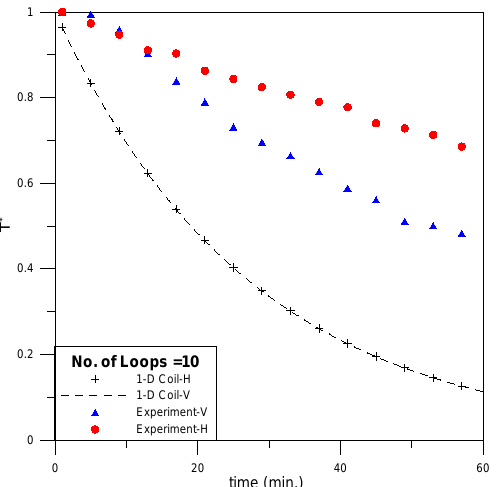
Figure 10. Effect of Reynolds number on the rate of heat transfer.